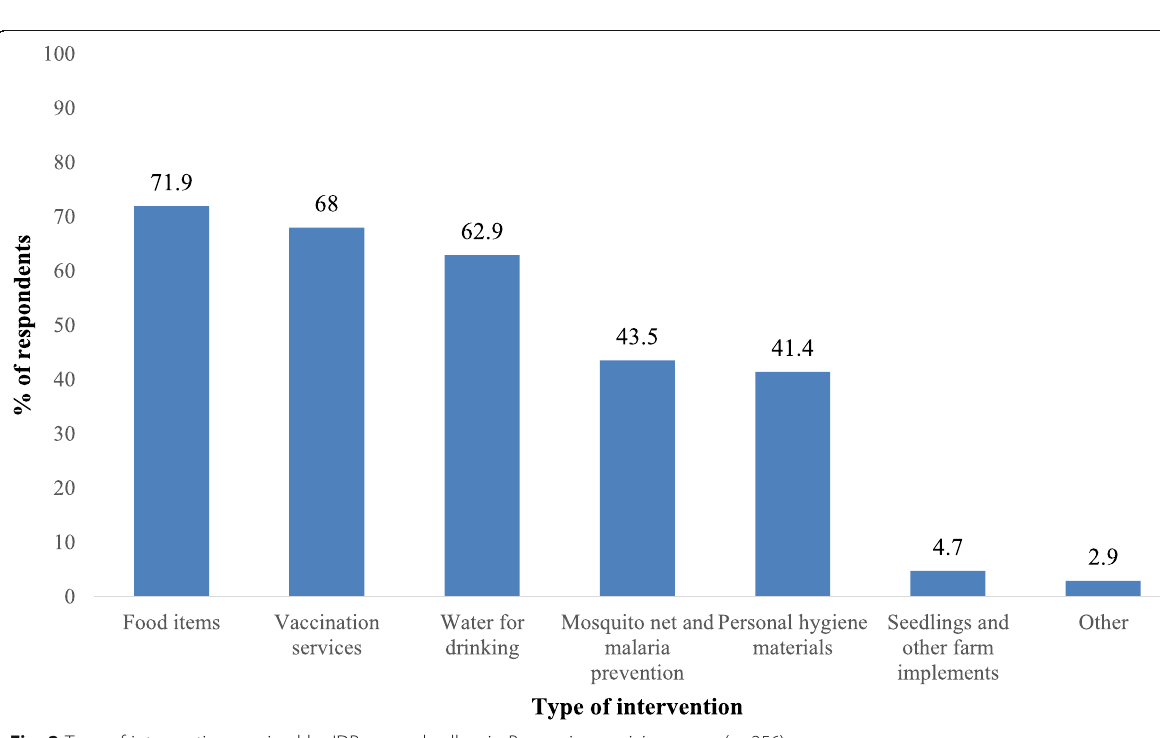
Fig. 2 Type of intervention received by IDP camp dwellers in Borno since arriving camp ( n